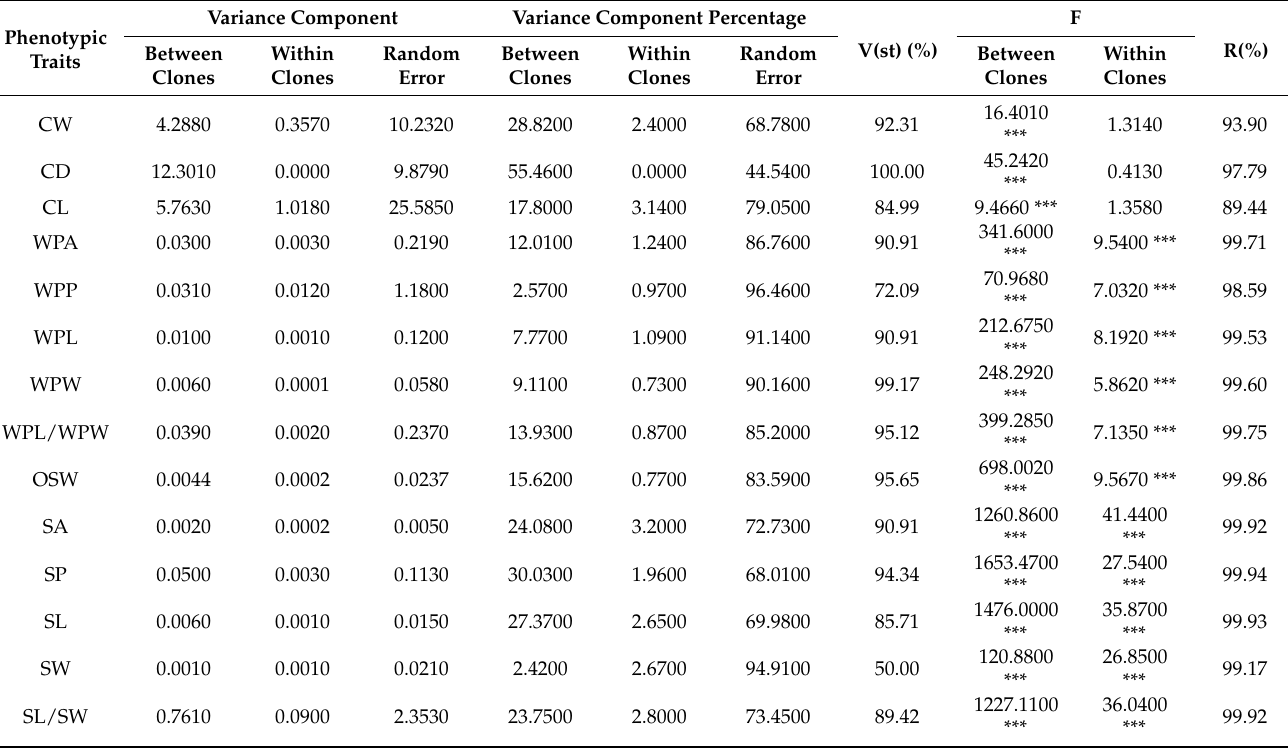
Table 3. Variance component, phenotypic differentiation coefficient, and repeatability of phenotypic characters of cones and seeds of Chinese fir clones in the upper and middle crown layers.